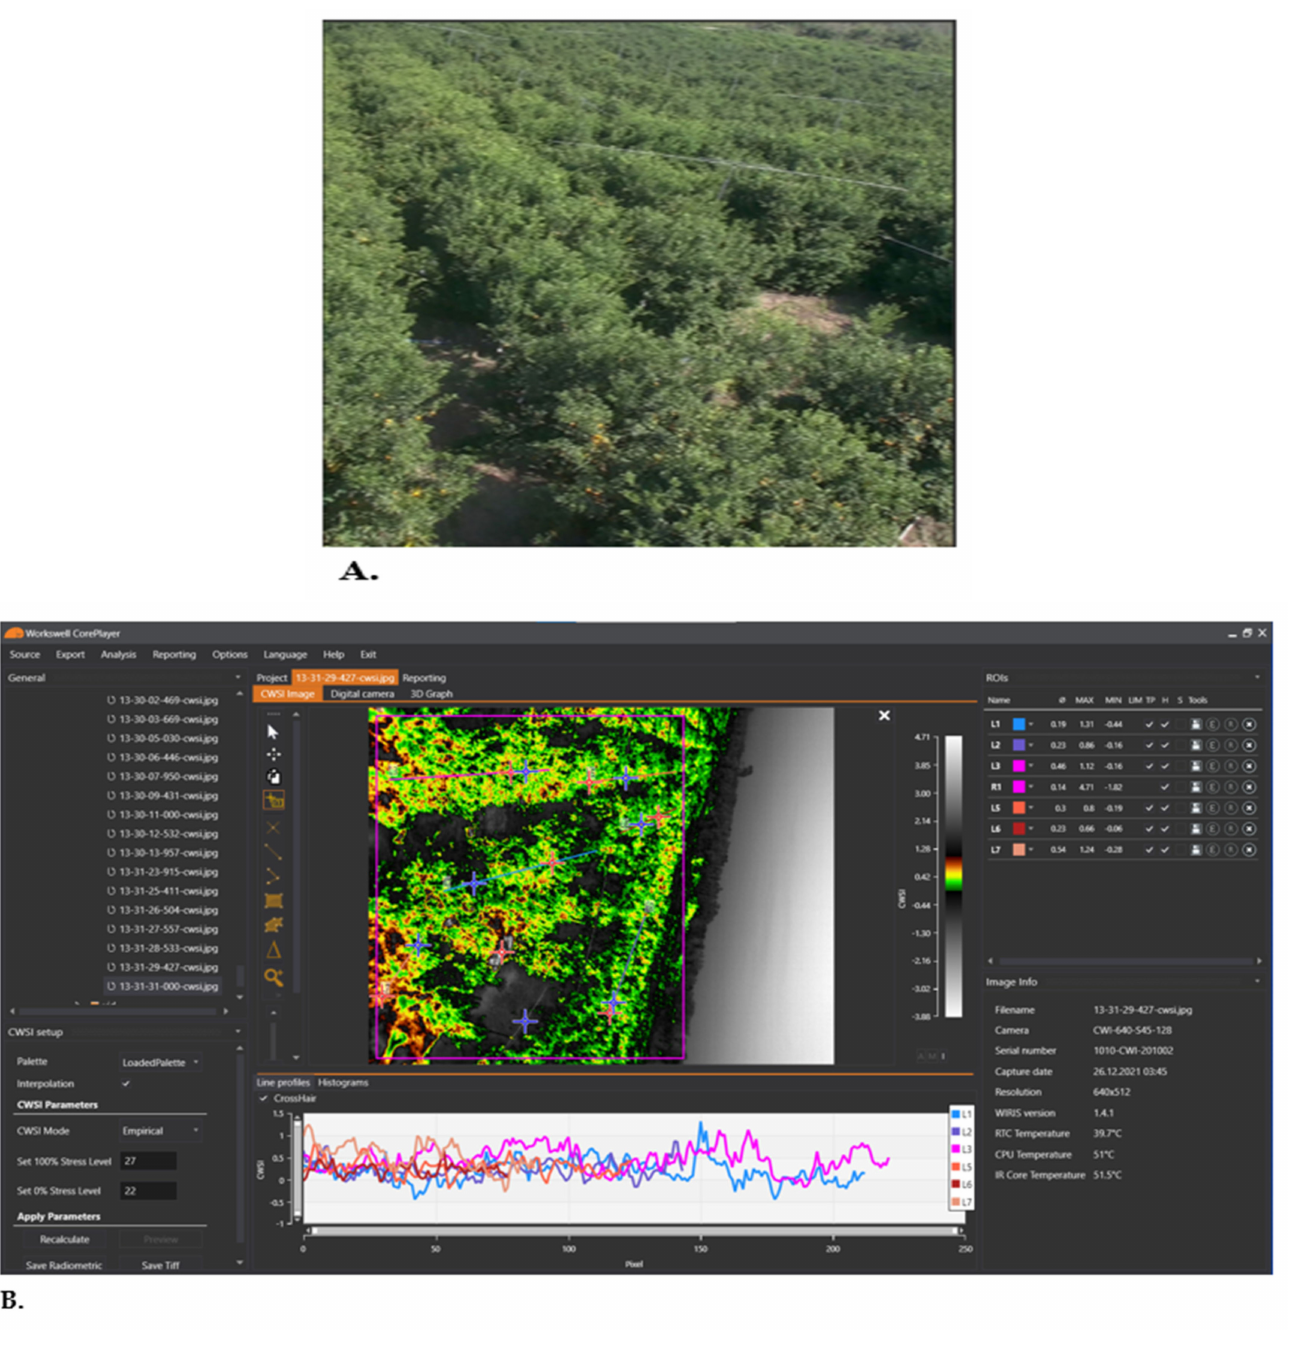
Figure 9. ( A ) digital imagery of the mandarin orchard. ( B ) Isothermal panel showing histogram of pixels and their corresponding CWSI values from the